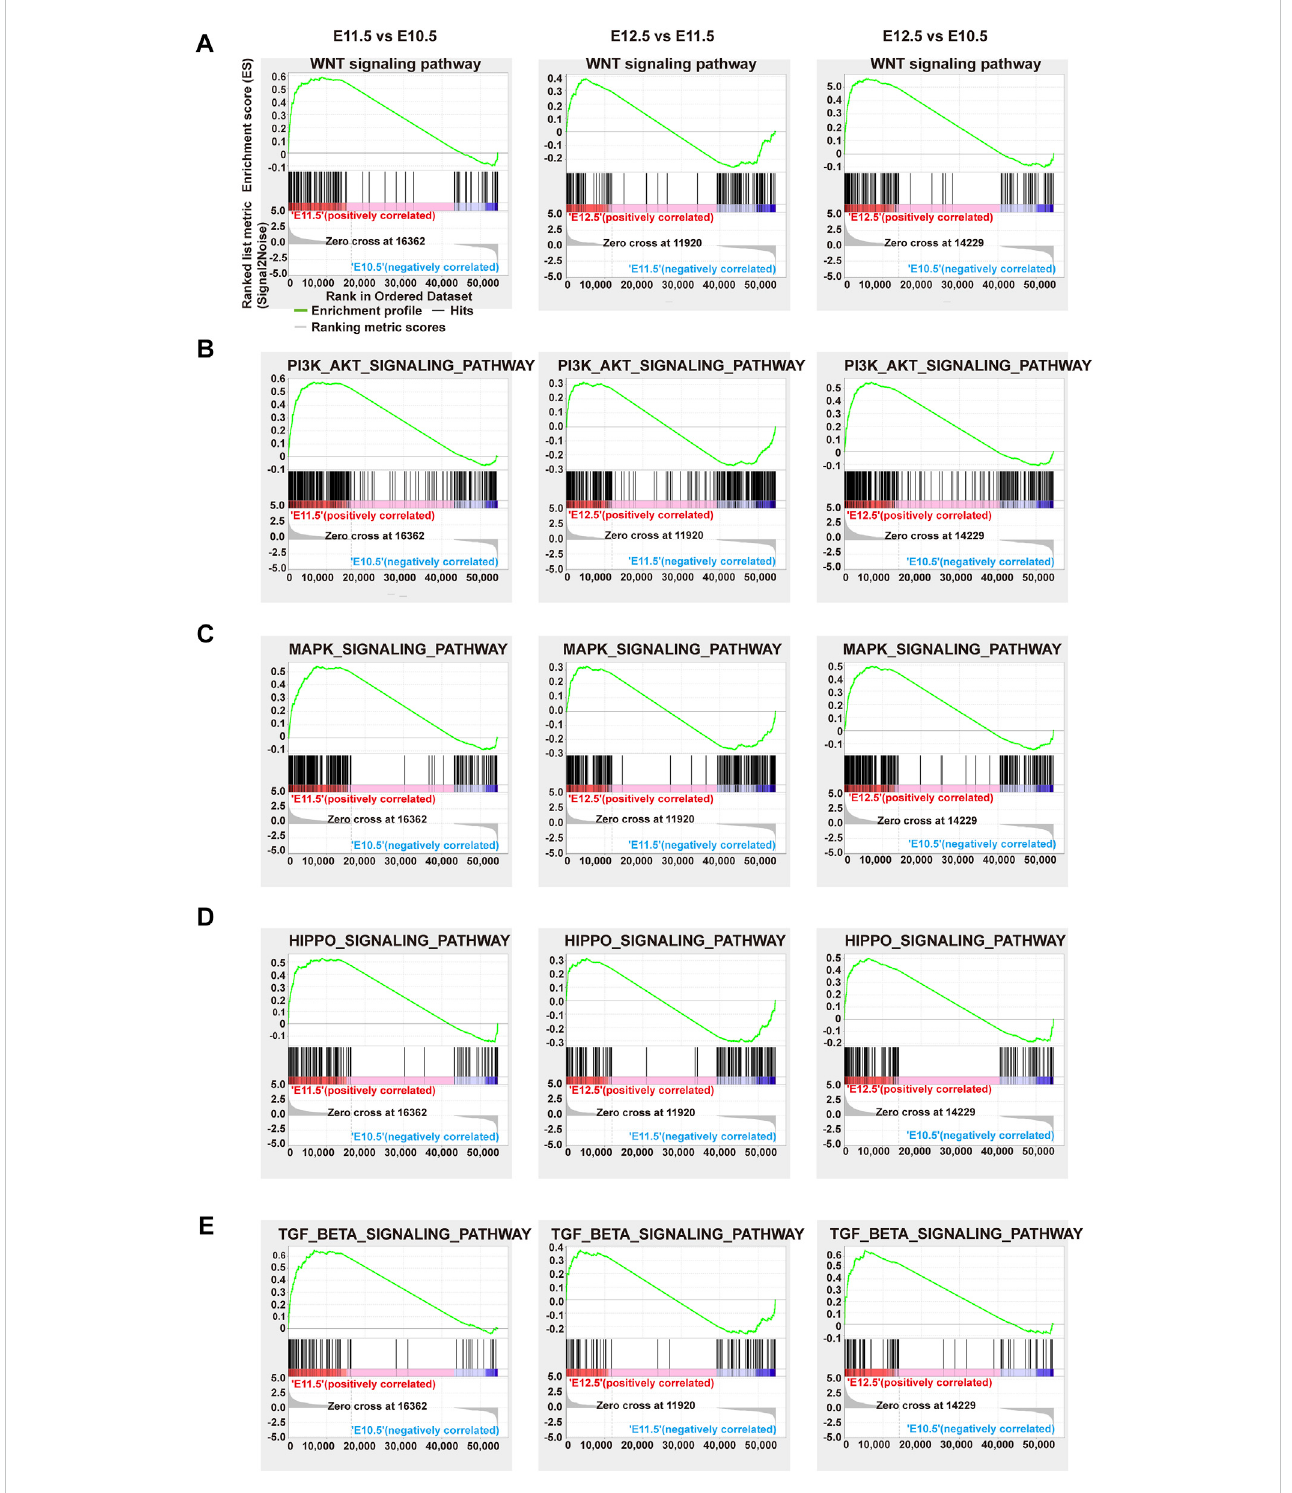
FIGURE 3 GSEAanalysisofrepresentativesigni fi cantsignalpathways.Genesetenrichmentplotsofthe (A) Wnt, (B) PI3K-AKT, (C) MAPK, (D) Hippo,and (E) Tgf-beta signaling pathways among comparison groups E11.5 vs. E10.5 (left), E12.5 vs. E11.5 (middle), and E12.5 vs. E10.5 (right), respectively. Green curve: enrichment score; vertical red or blue bars: gene